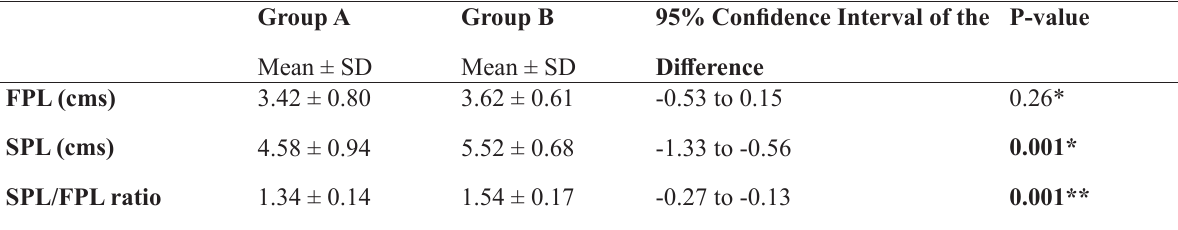
Table 3. Comparison of FPL, SPL and SPL/FPL ratio between the two